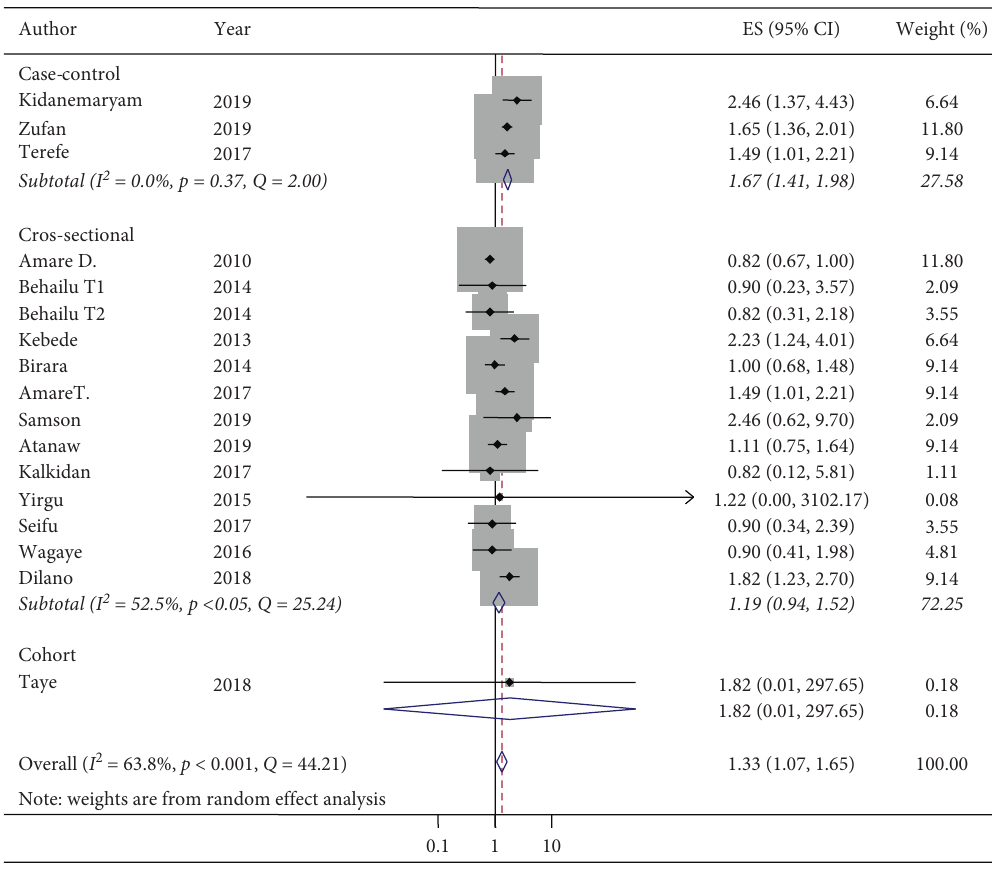
Figure 6: Subgroup analysis (by design) on the association of medium wealth index with stunting and its 95% CI in Ethiopia,